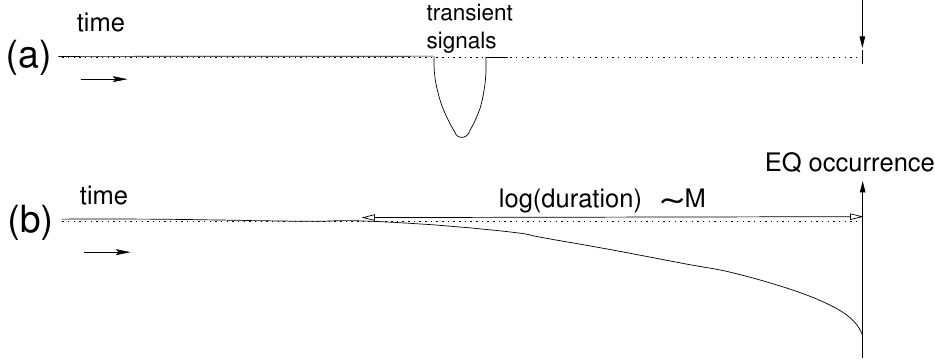
Figure 2. Schematic diagram showing the two distinct approaches proposed for a precursory behavior whose intensity is quantified by the deflection from the horizontal axis, i.e., the y -axis. ( a ) The case of the physical model for SES generation, which differs greatly from other suggested mechanisms [22] in which the anomalous precursory behavior becomes more intense upon approaching the EQ occurrence ( b ). Taken from Ref.